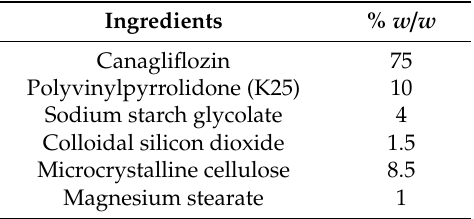
Table 10. The quantitative composition of canagliflozin tablet formulation.